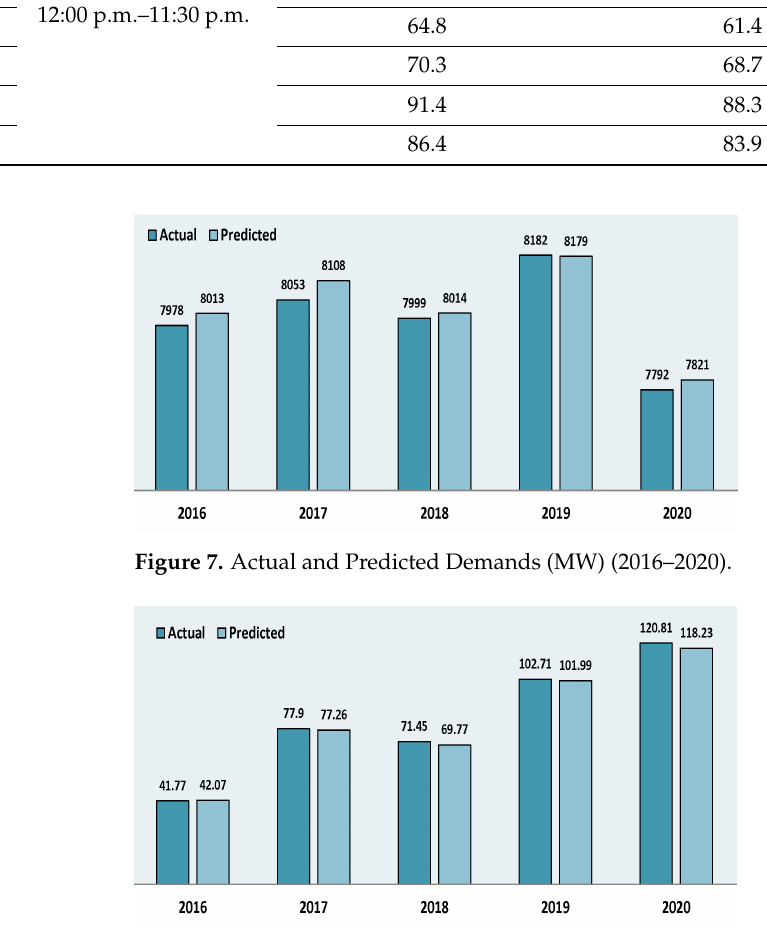
Figure 8. Actual and Predicted Price (USD/MWh)